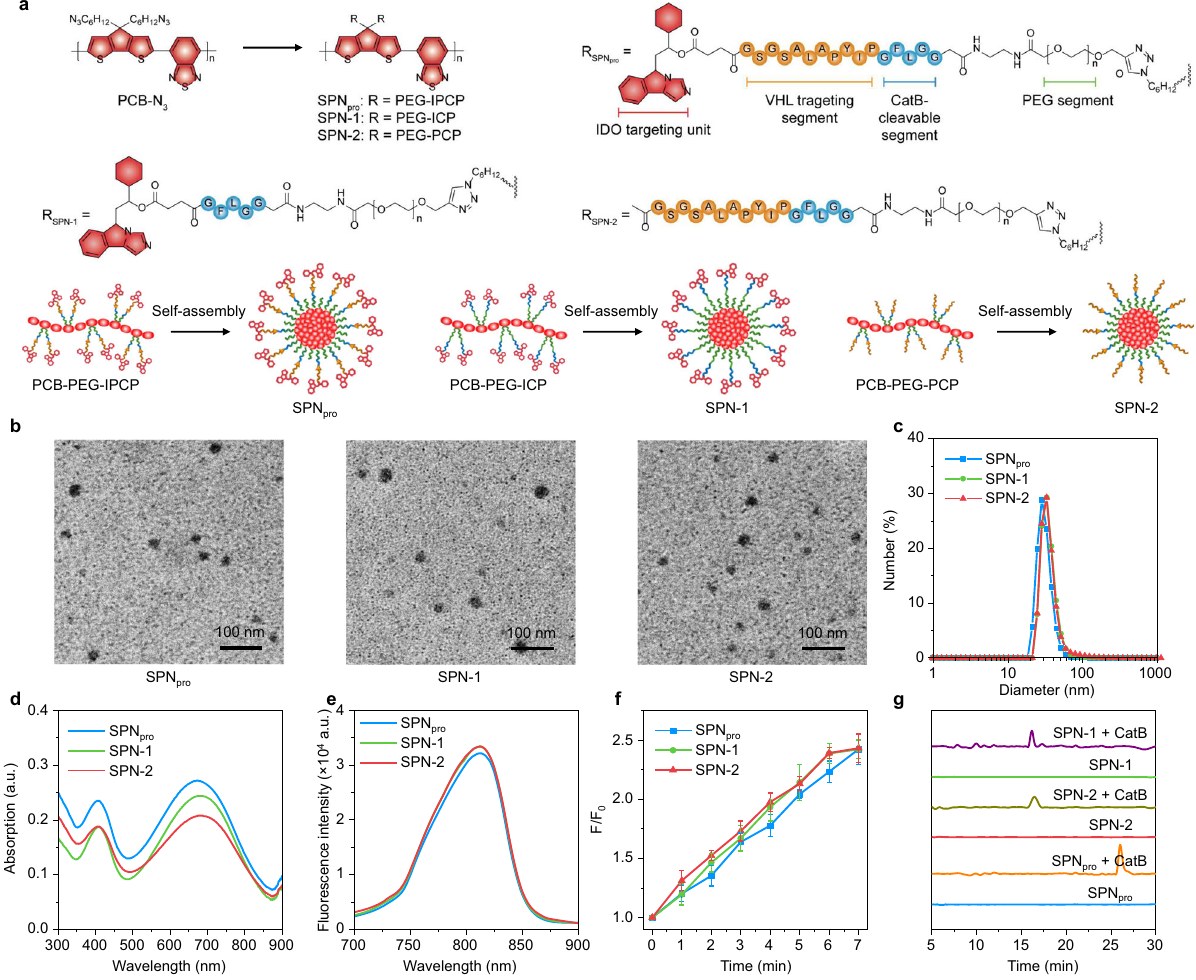
Fig. 2 Synthesis and characterization of SPN pro , SPN-1, and SPN-2. a The molecular structures and syntheses of SPN pro , SPN-1, and SPN-2. b TEM images